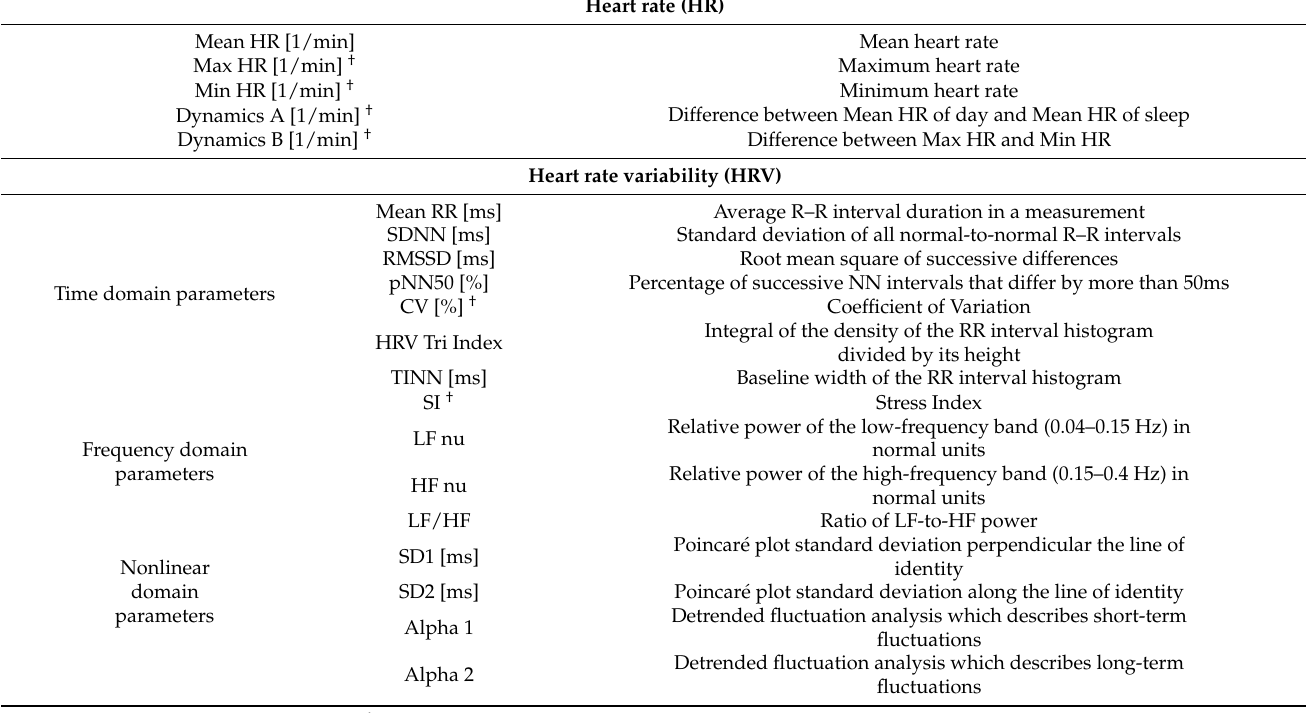
Table 1. Overview and definitions of examined heart rate (HR) and heart rate variability (HRV)